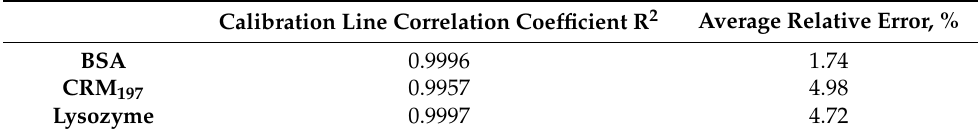
Table 5. Correlation coefficients and average relative errors of the capillary electrophoresis calibration curves used for quantification of BSA, CRM 197 and